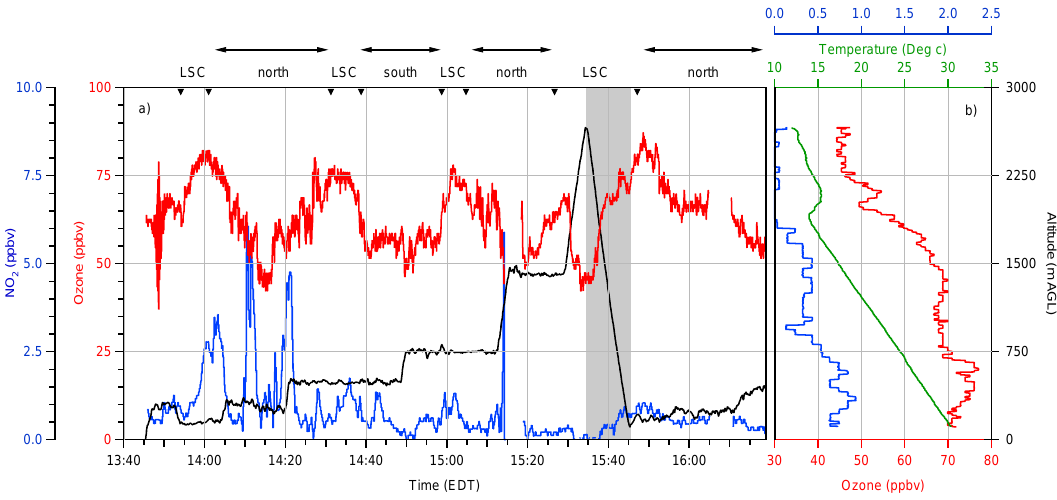
Fig. 11. (a) Twin Otter time series of O 3 , NO 2 , and elevation; (b) vertical profiles of O 3 , NO 2 , and temperature over Lake St. Clair. Profile period is indicated as shaded area. Top notation refers to periods when the aircraft is located over, to the north, or to the south of Lake St. Clair